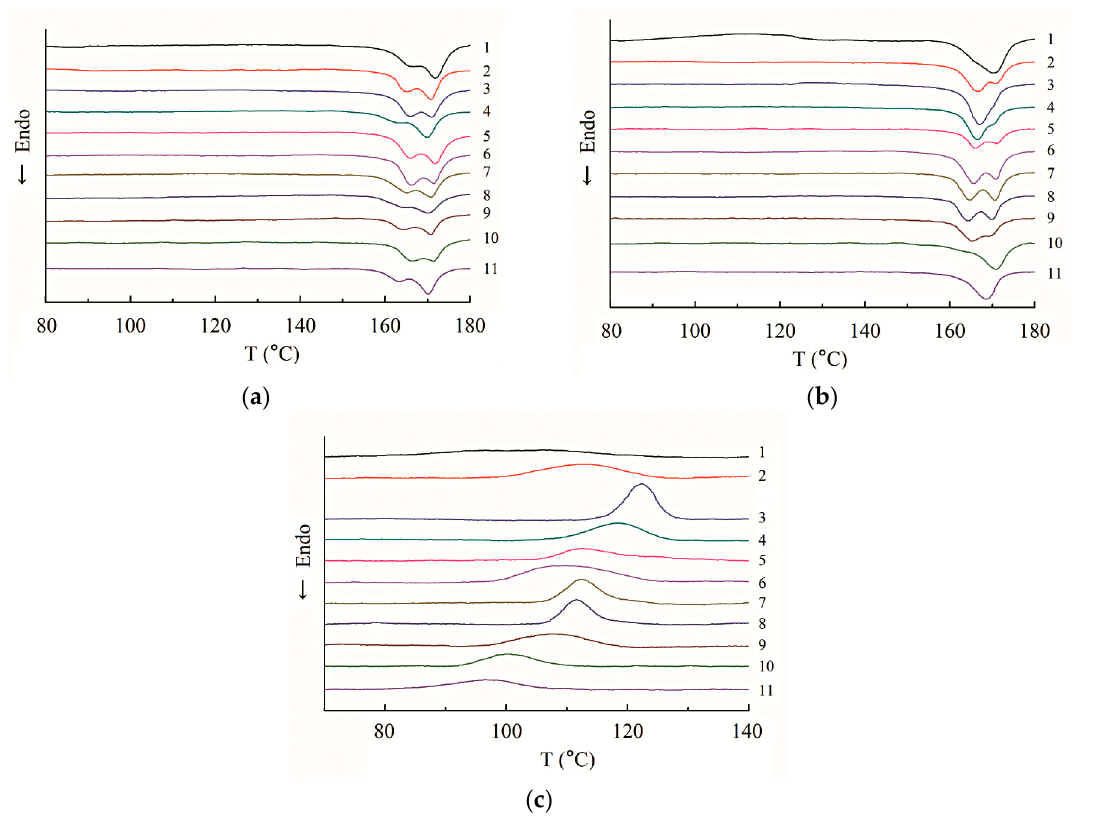
Figure 8. Differential scanning calorimetry curves of isothermally crystallized samples. ( 1 ) PLA; ( 2 ) PLA/PF (90 wt %/10 wt %); ( 3 ) PLA/PF (80 wt %/20 wt %); ( 4 ) PLA/PF (70 wt %/30 wt %);